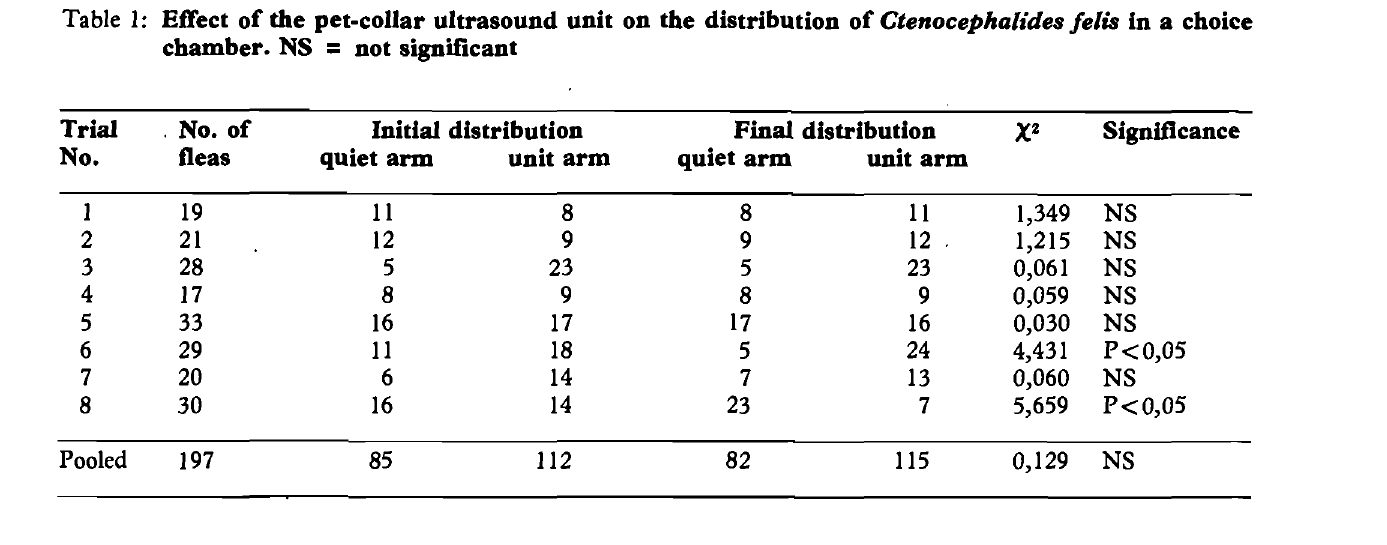
Table 1: Effect of the pet-collar ultrasound unit on the distribution of Ctenocephalides felis in a choice = chamber. NS not significant